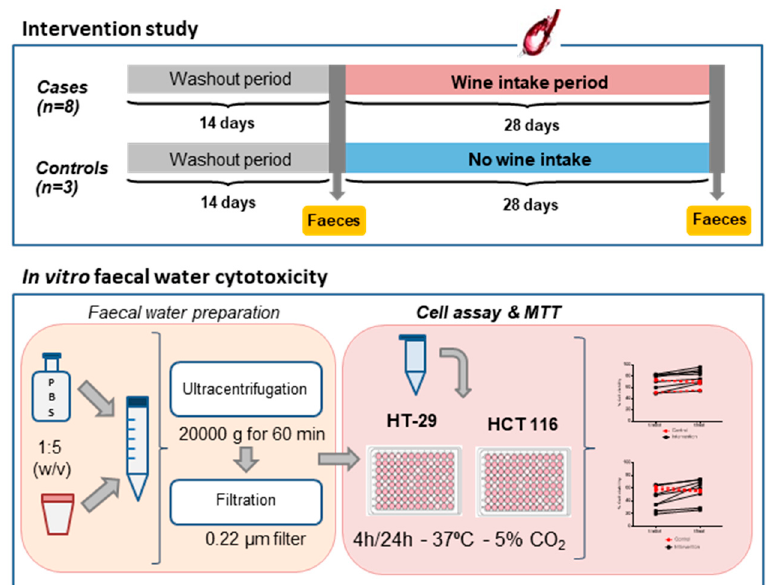
Figure 1. Flow chart of the experimental approach followed in this study.